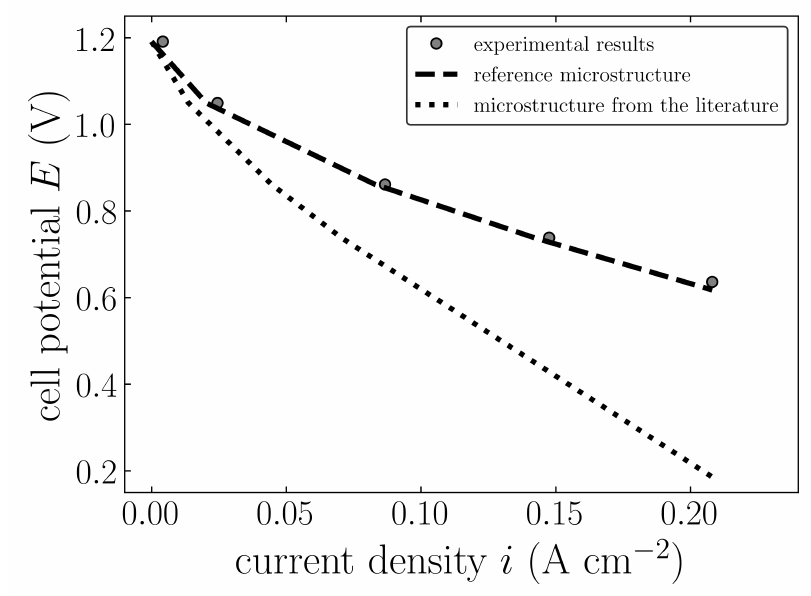
Figure 15. Comparison of the computations with two different microstructure parameters with the experimental results for T fur = 650 ◦ C, χ H